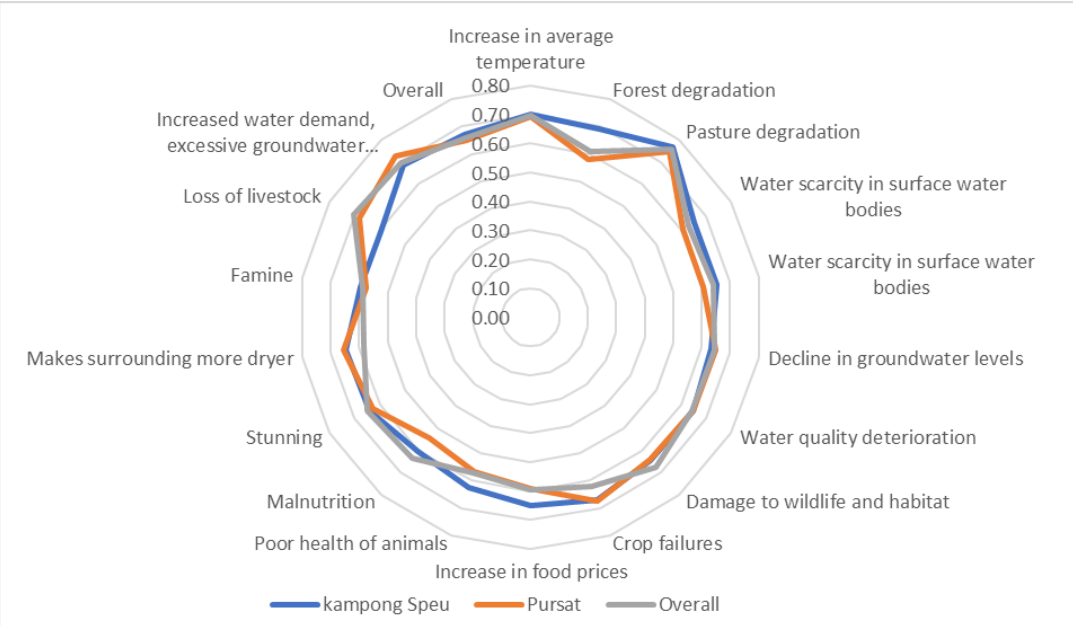
Figure 4. The degrees of drought impact on livelihood. Notes: WAI = the weight average index is applied to measure on a five-point scale (very low (VL) = 0.00–0.20, low (L) = 0.21–0.40, moderate (M) = 0.41–0.60, high (H) = 0.61–0.80, and very high (VH) = 0.81–1.00). OA = overall assessment. p -value <0.05. p -value: Increase in average temperature = 0.659; forest degradation = 0.014; pasture degradation = 0.363; water scarcity in surface water bodies = 0.029; the decline in groundwater levels = 0.392; water quality deterioration = 0.982; damage to wildlife and habitat = 0.961; crop failures = 0.931; increase in food prices = 0.001; poor health of animals = 0.010; malnutrition = 0.001; stunning = 0.560; making the surroundings more dry = 0.716; famine = 0.342; loss of livestock = 0.661; increased water demand; excessive groundwater pumping = 0.040; and the overall impact on livelihood = 0.064.